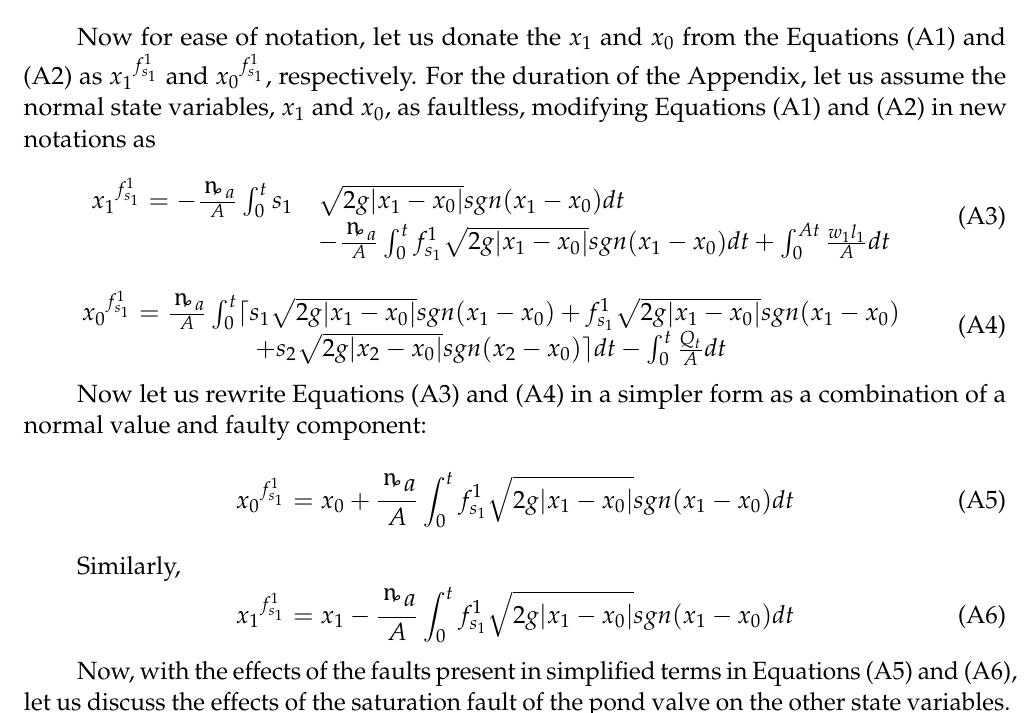
Figure 1. Three-pond hydraulic system.